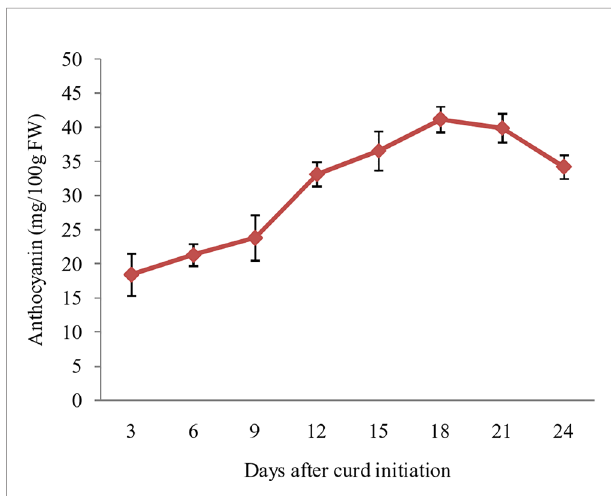
FIGURE 6 | Anthocyanin content in ‘ PC-1 ’ at different days after curd